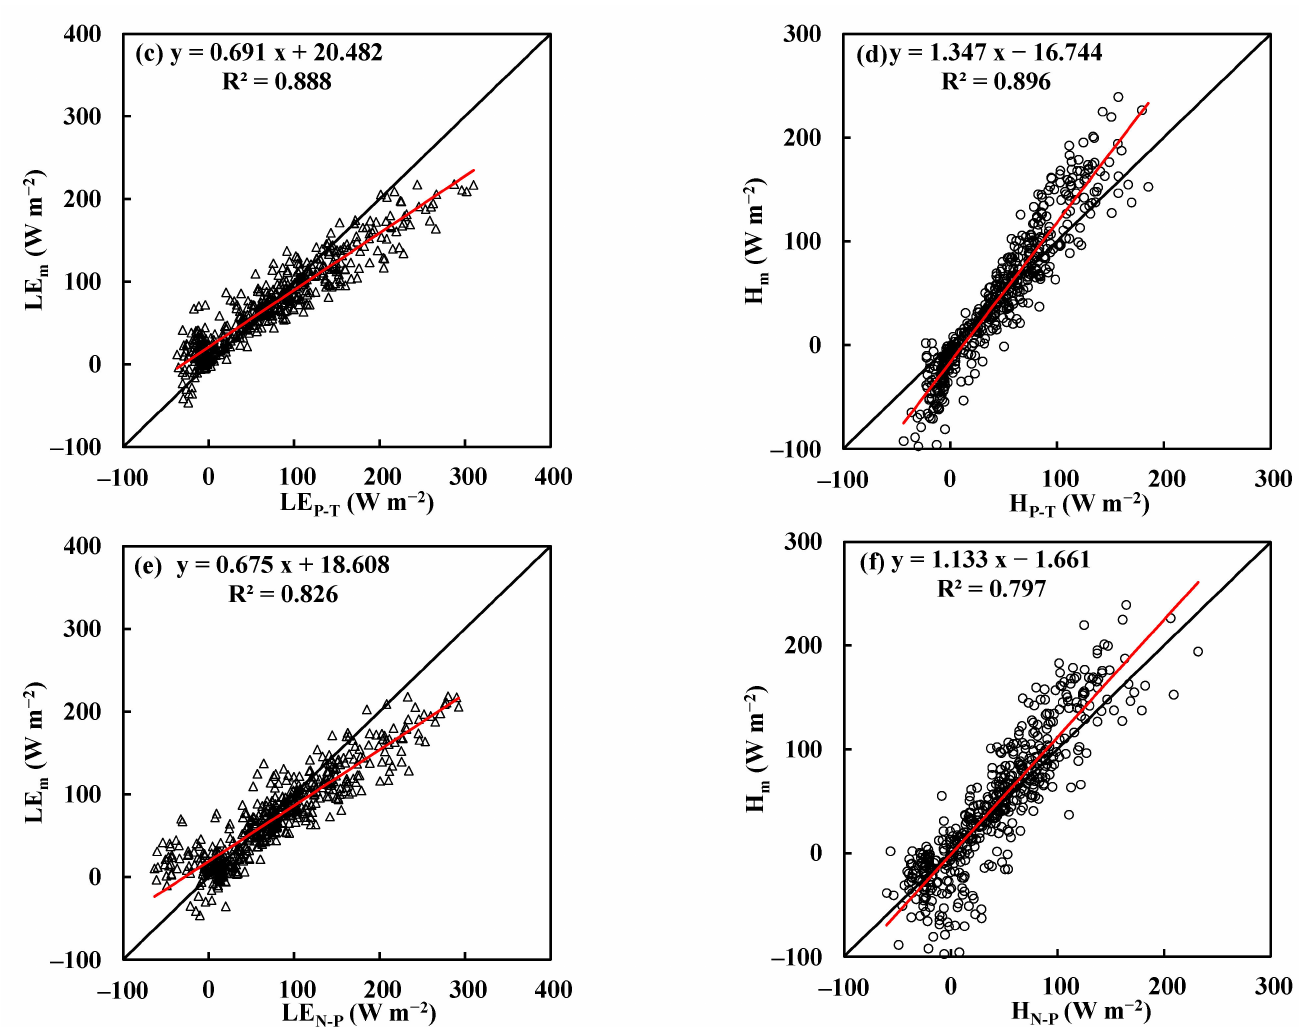
Figure 6. Comparisons of measured and predicted LE and H by the P–M equation ( a , b ), P–T equation ( c , d ), and non-parametric method ( e , f ) above the peat bog. The 1:1 line is also shown. Further model performance evaluation was done by plotting the measured and model- predicted LE and H values as a function of available energy (R n − G) at the peat bog (Figure 7). From Figure 7 it appears for the cases of high available energy (R n − G > 300), all three of the models slightly overpredicted LE. This shows that the actual evapotranspiration rate was slightly lower than the equilibrium evaporation rate when the available energy was large. This reduction of evapotranspiration might have been caused by resistance from the vegetation in order to reduce water loss during higher air temperature and